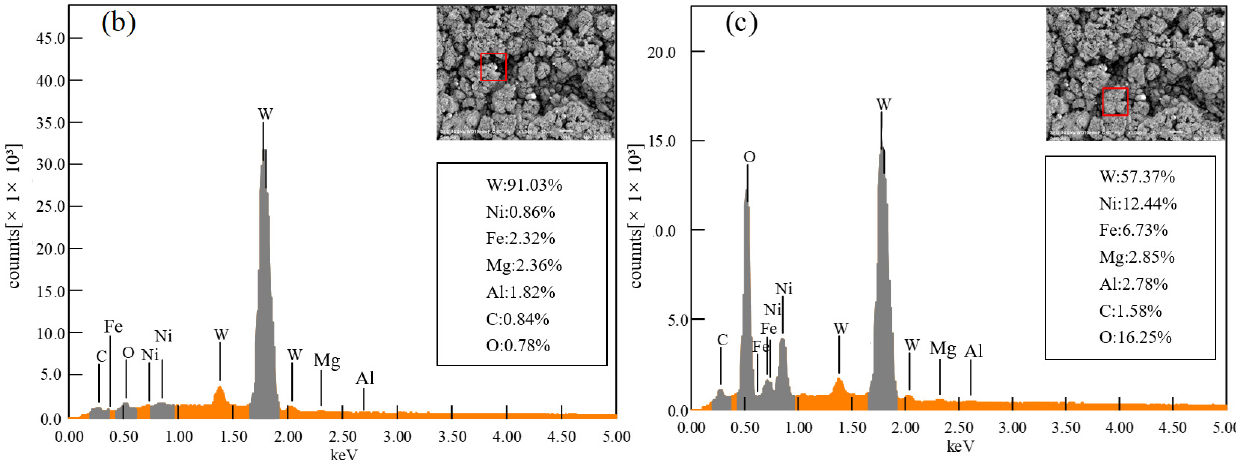
Figure 5. EDS inspection of laser ablation tungsten alloy at different positions; ( a ) SEM morphology of laser ablation tungsten alloy surface; ( b ) EDS of pure tungsten position; ( c ) blended recondensing position.